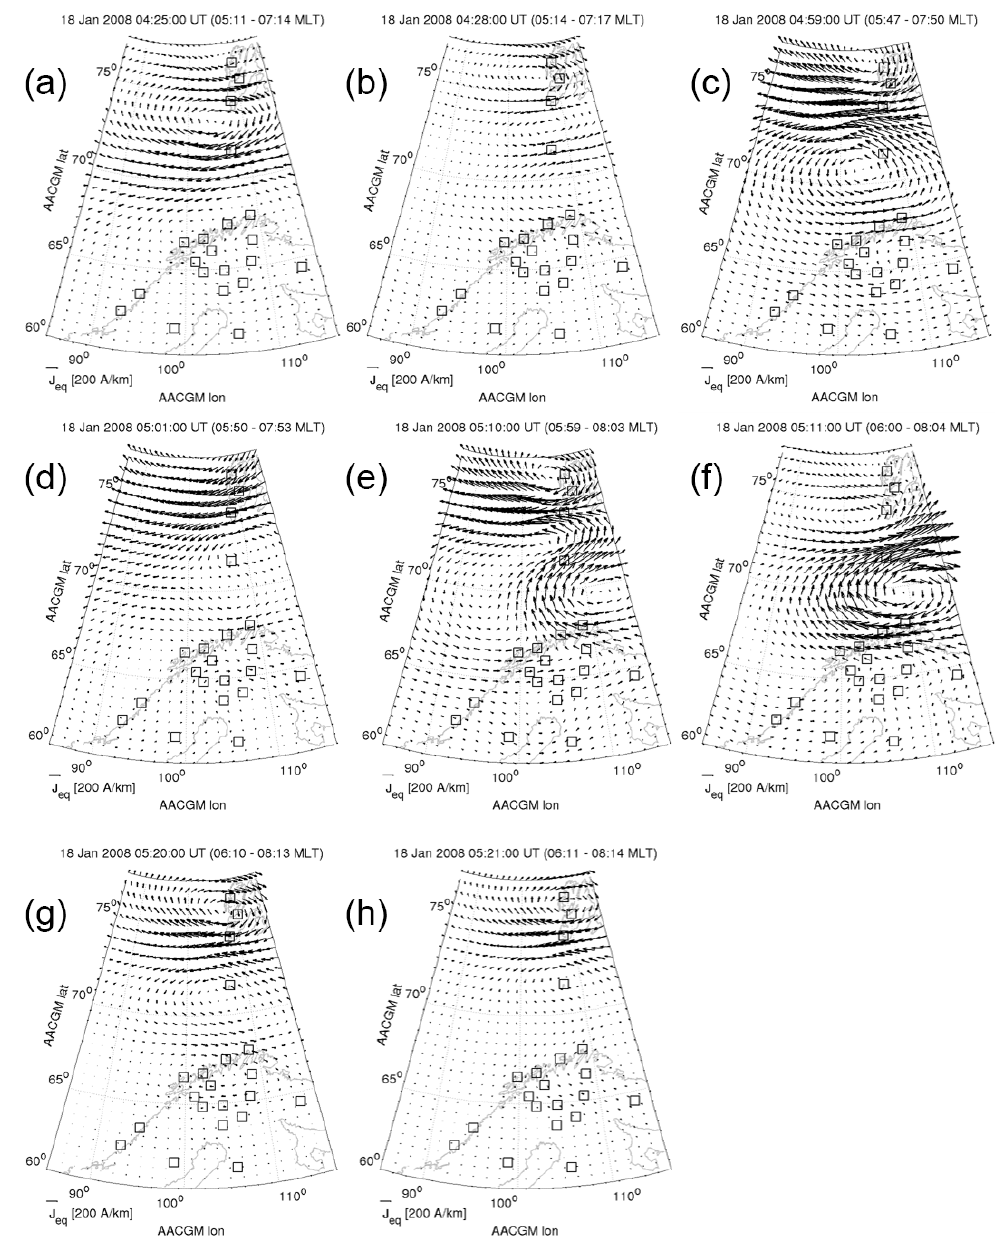
Figure 6. Examples of 2-D equivalent current plots derived from IMAGE magnetometer data recorded on 18 January 2008. Maps are presented in altitude-adjusted corrected geomagnetic coordinates (AACGMs, Baker and Wing, 1989).